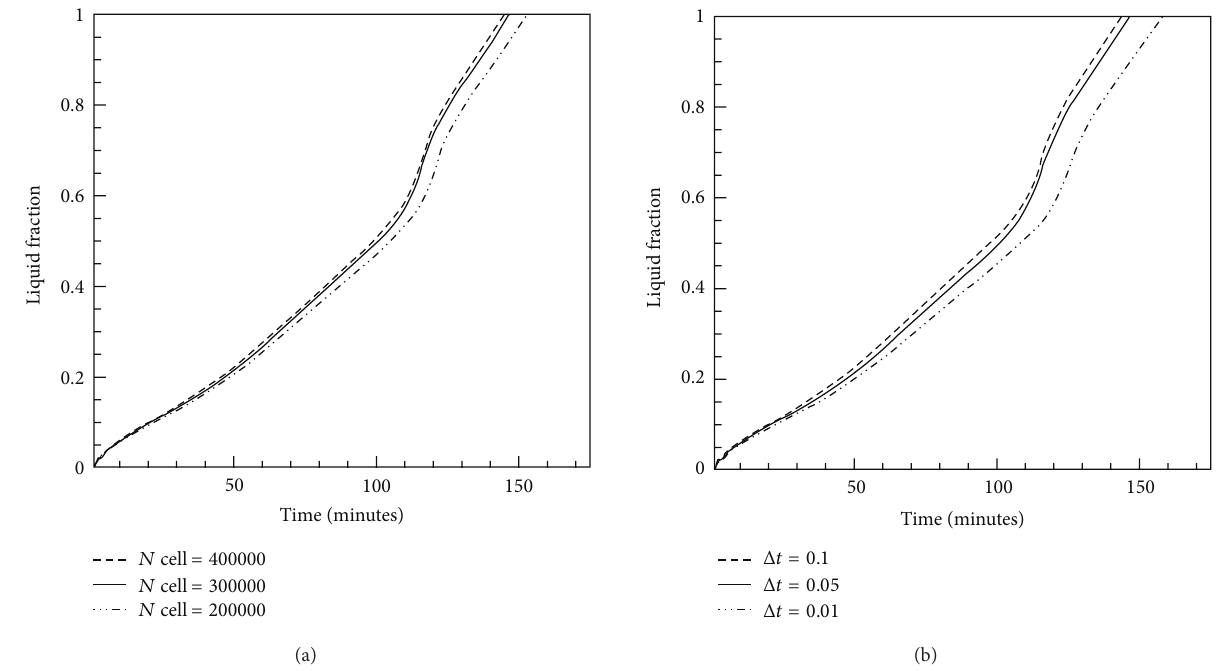
Figure 2: Effects of (a) grid size and (b) time step on the variation of liquid fraction with time.